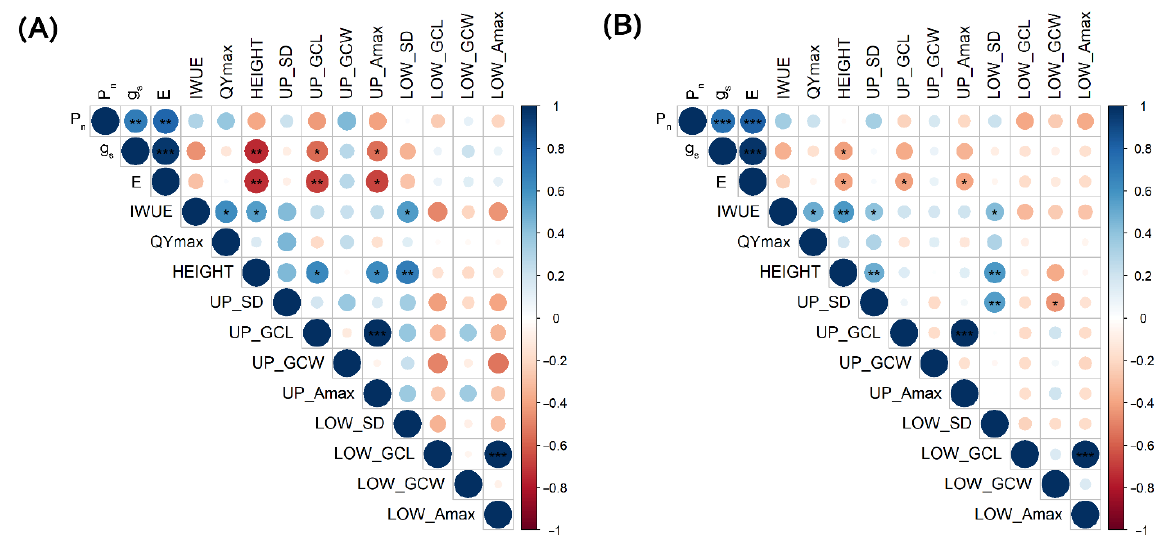
Figure 1. Correlation matrix for among physiological and stomatal morphological traits ( A ) under drought stress and ( B ) plasticity in KDML105-CSSLs. Positive and negative correlations are illustrated in blue and red circles, respectively. Color shade and circle size are proportional to the correlation coefficients, with their values shown in the color intensity bar. Significance level is indicated as * ( p < 0.05 ‘*’, p < 0.01 ‘**’, p < 0.001 ‘***’); Net photosynthesis rate (P n ); Stomatal conductance (g s ); Transpiration rate (E); Intrinsic water-use efficiency (IWUE); Maximum PSII quantum yield (QYmax); Rice height (HEIGHT); Upper stomatal density (UP_SD); Upper guard cell length (UP_GCL); Upper guard cell width (UP_GCW); Upper maximal pore area (UP_Amax); Lower stomatal density (LOW_SD); Lower guard cell length (LOW_GCL); Lower guard cell width (LOW_GCW); Lower maximal pore area (LOW_Amax).